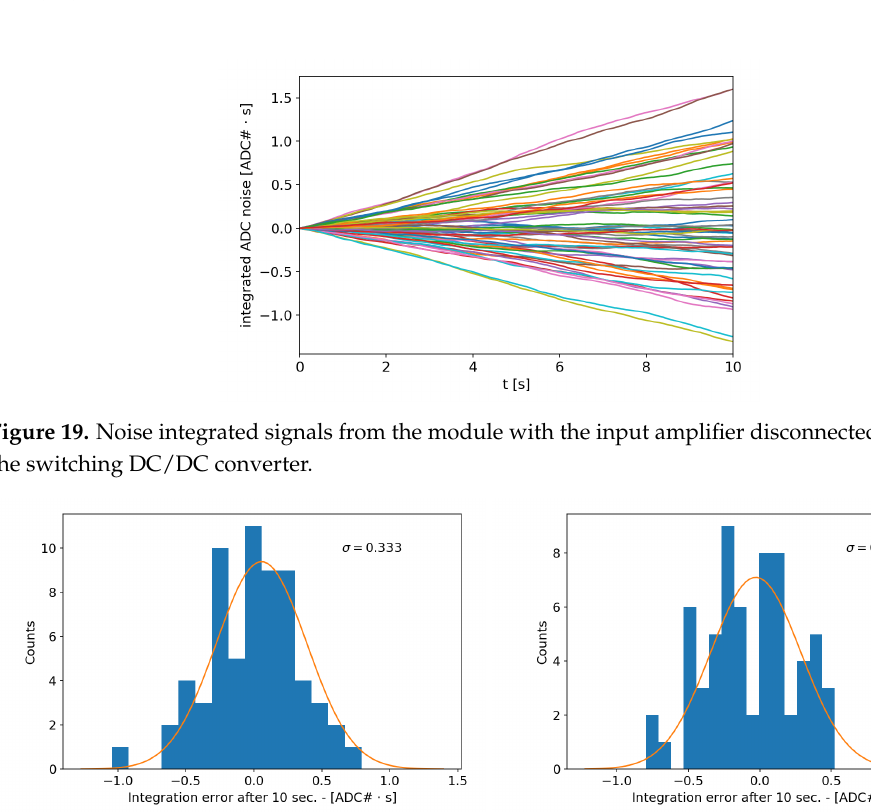
Figure 20. Histograms of the final integration values due to the integrated noise with DC/DC ( left ) and linear power supply ( right ).